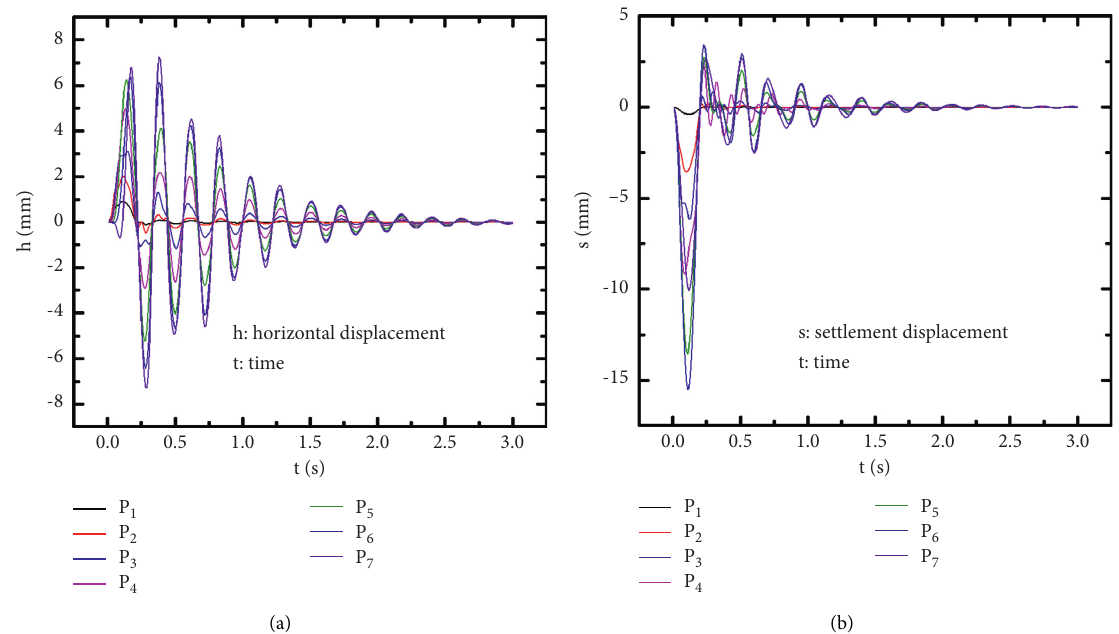
Figure 9: Horizontal displacement and settlement curve of slope time-history analysis.